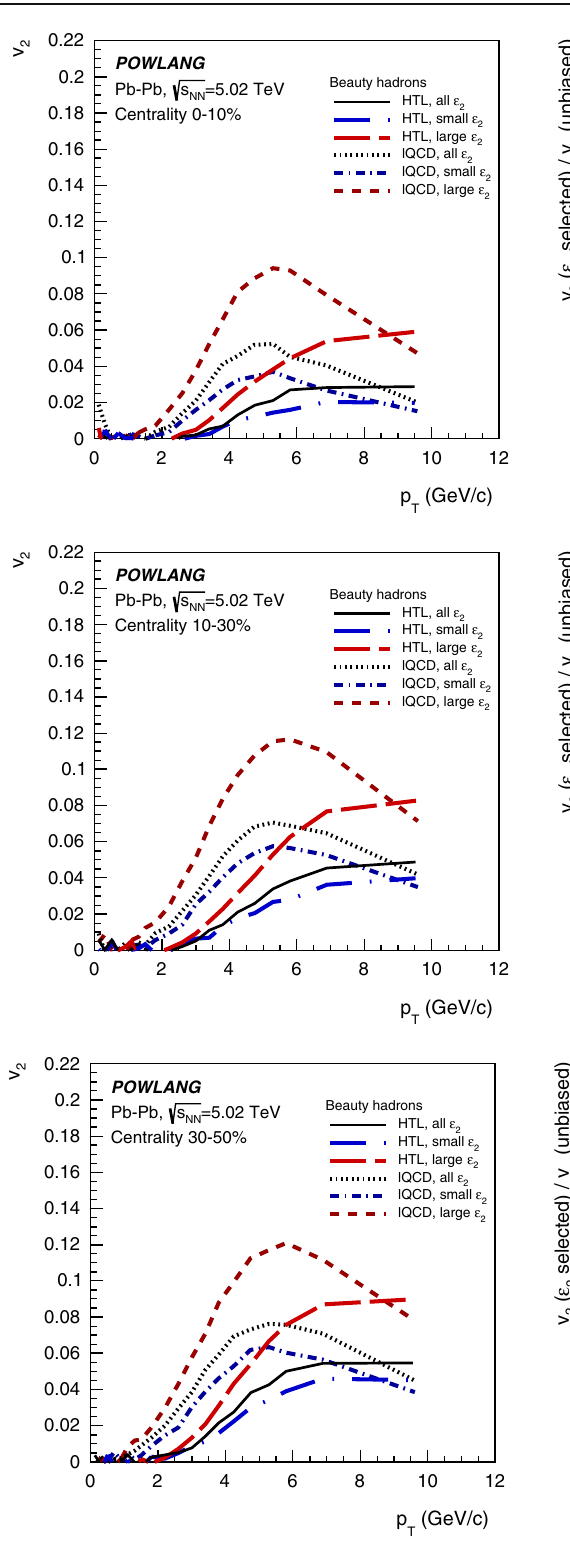
Fig. 16 Theelliptic-flowcoefficient v 2 ofbeautyhadronsinthe0–10% (top), 10–30% (middle) and 30–50% (bottom) most central Pb–Pb col- √ s NN = 5 . 02 TeV. Results for the 20% highest- (cid:7) 2 and to the lisions at